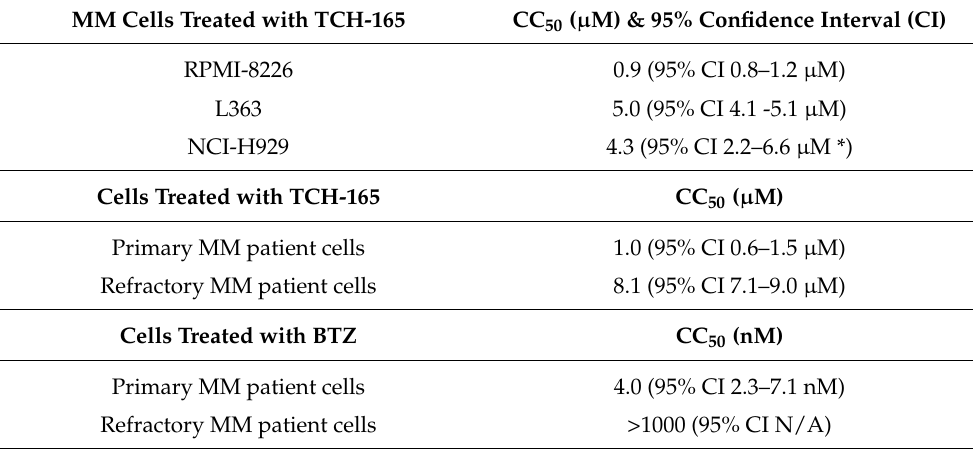
Table 1. CC 50 values of MM cell lines and patient cells. Cytotoxicity of TCH-165 in human RPMI- 8226 (CC 50 0.9 µ M; 95% CI 0.8–1.2 µ M), L363 (CC 50 5.0 µ M; 95% CI 4.1 − 5.1 µ M), NIH-H929 (CC 50 4.3 µ M; 95% CI 2.2.8–6.6 µ M) cells after 72 h treatment, as well as primary human MM cells of newly diagnosed patient (CC 50 1.0 µ M; 95% CI 0.6–1.5), relapsed patient (CC 50 8.1 µ M; 95% CI 7.1–9.0 µ